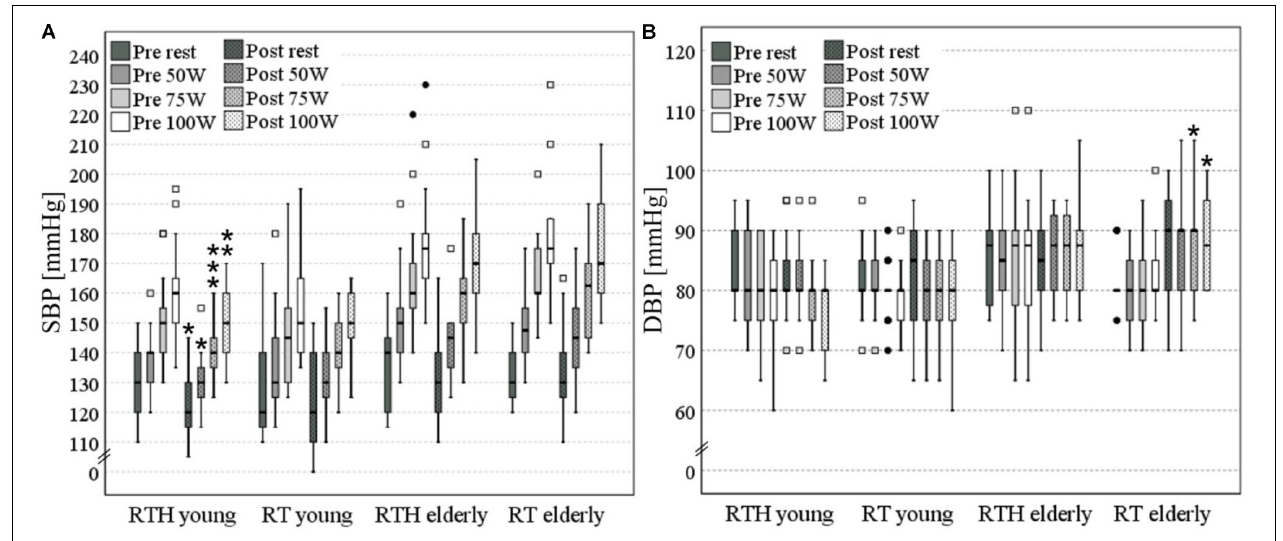
FIGURE 5 | Systolic (A) and diastolic (B) blood pressure (SBP, DBP) at rest, 50, 75, and 100 W [significant pre-post- differences are marked with an asterisk (*) above the box plots: one * p ≤ 0.050, two vertical * p ≤ 0.010, three vertical * p ≤ 0.001; values with a distance of the 1 st or 3 rd quartile of more than 1.5-fold ( (cid:3) ) or 3-fold ( • ) of the interquartile range are separately shown as